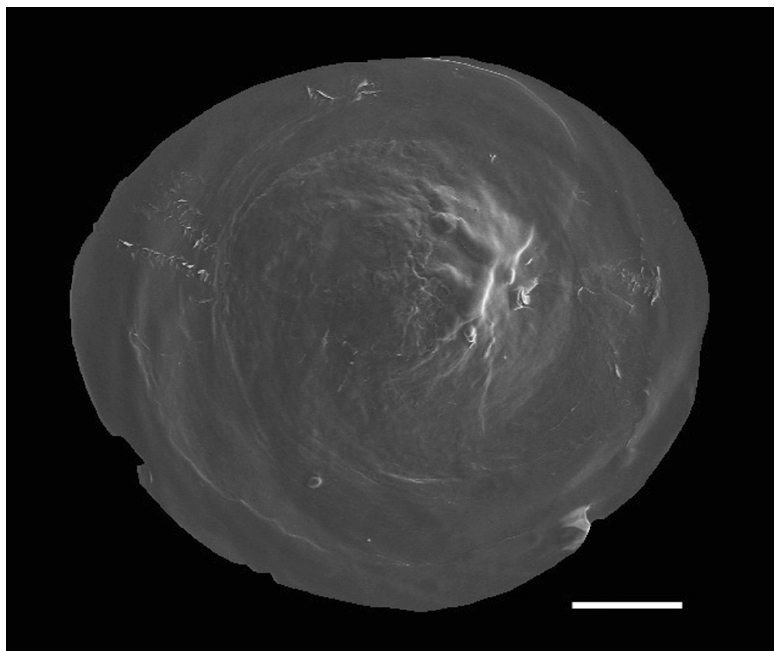
Fig. 19. Operculum of H. steffeki sp. nov., from type locality; internal side. Scale bar = 100